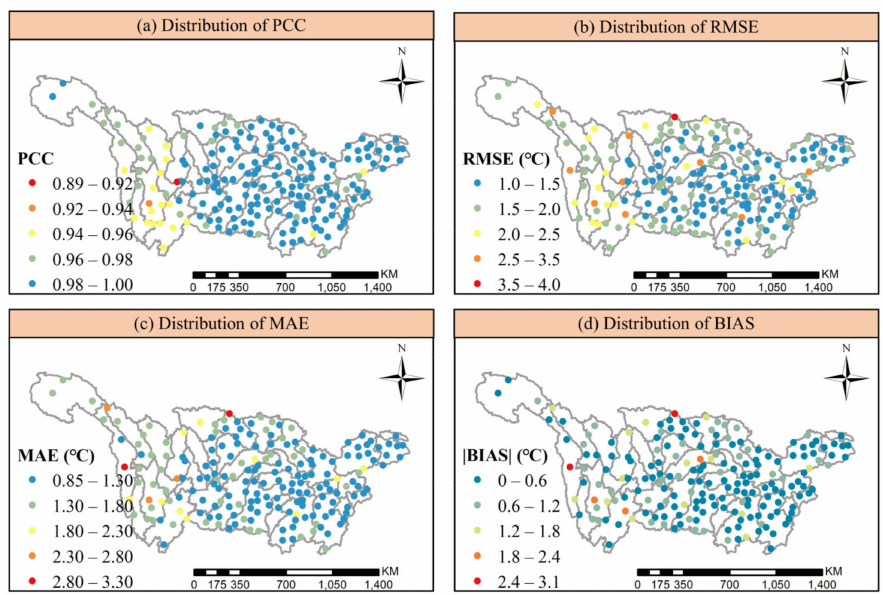
Figure 6. The spatial distribution of statistical metrics for 20 validation sites in YRB. ( a – d ) represent the distribution of PCC, RMSE, MAE, and